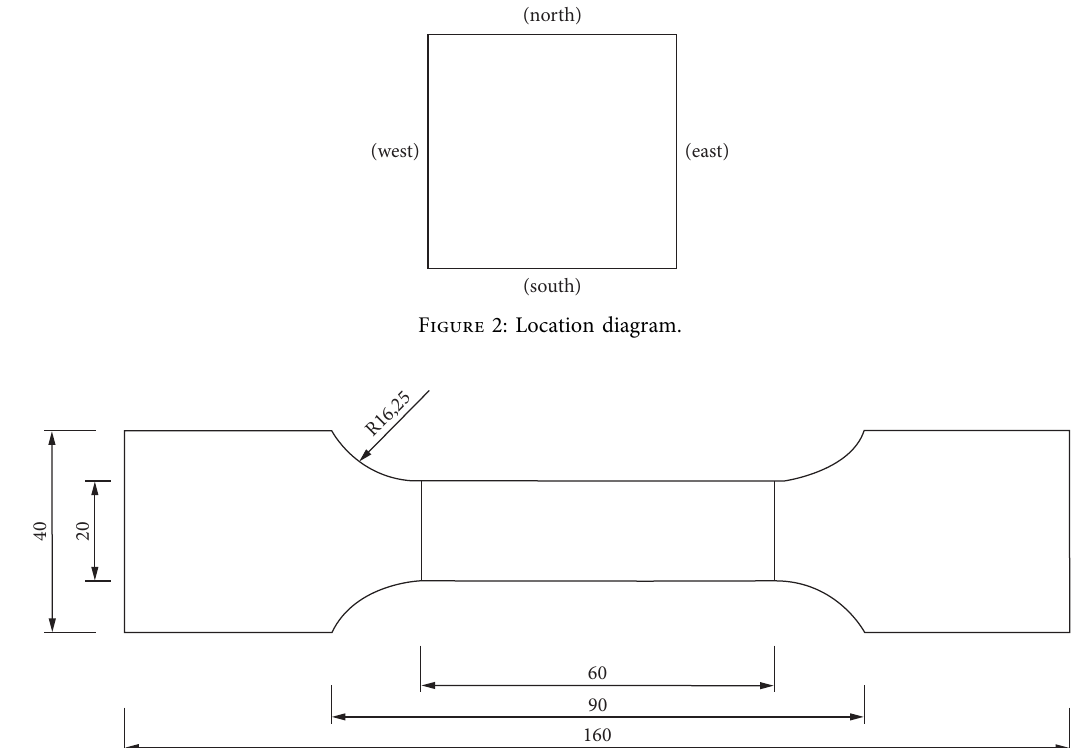
Figure 3: Plate sample